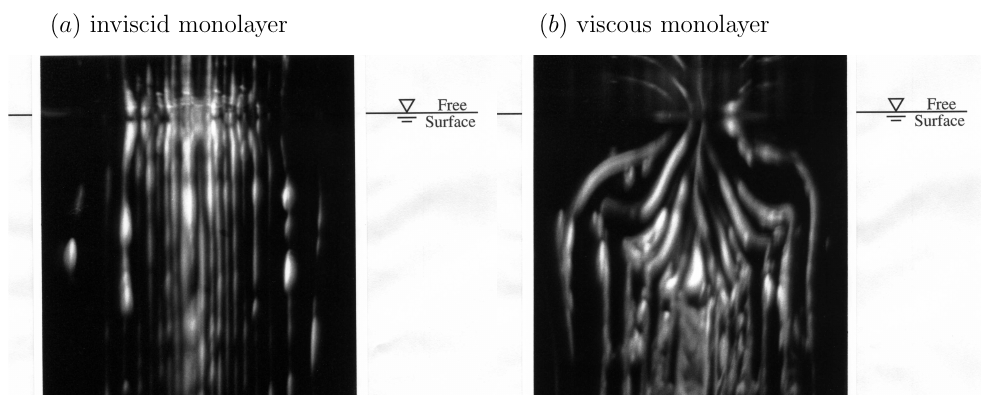
Figure 1. Photographs of a columnar vortex at an air–water interface with ( a ) a low surface shear viscosity monolayer, oleyl alcohol, and ( b ) a relatively viscous monolayer, stearic acid. The length scale of the experiment is 10cm and the Reynolds number is 10 3 . (Reproduced with permission ∼ ∼ from [50], published by AIP Publishing